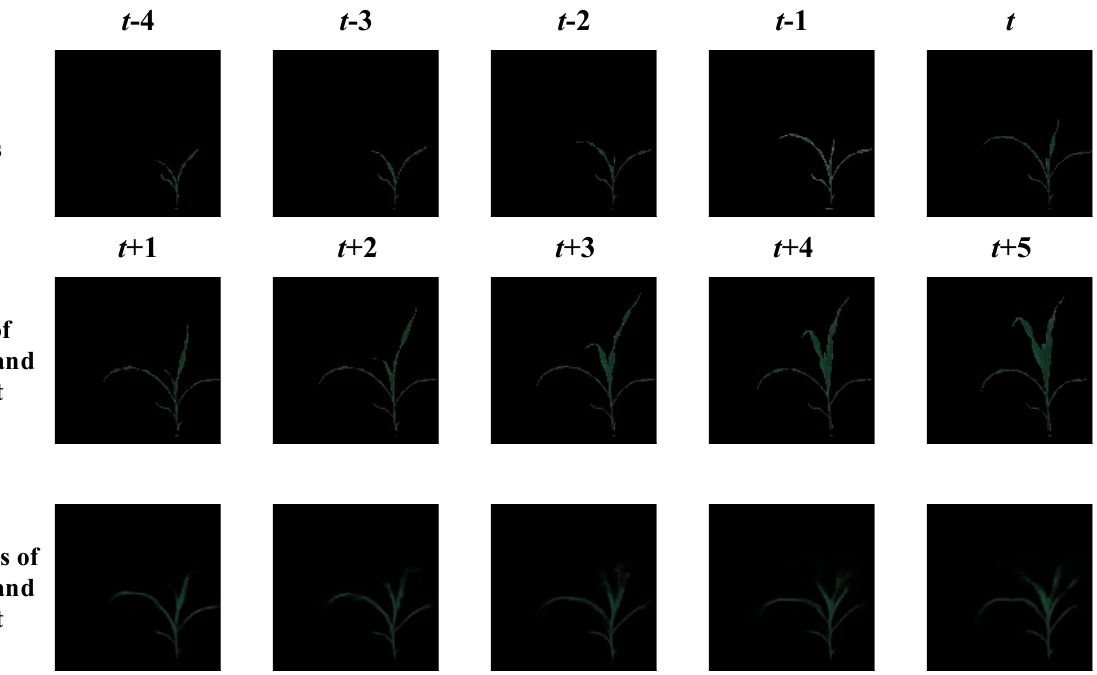
Figure 10. Comparison between the predicted images of panicoid grain crops and the real images of future growth and development of the experimental results on the Panicoid Phenomap-1 dataset.